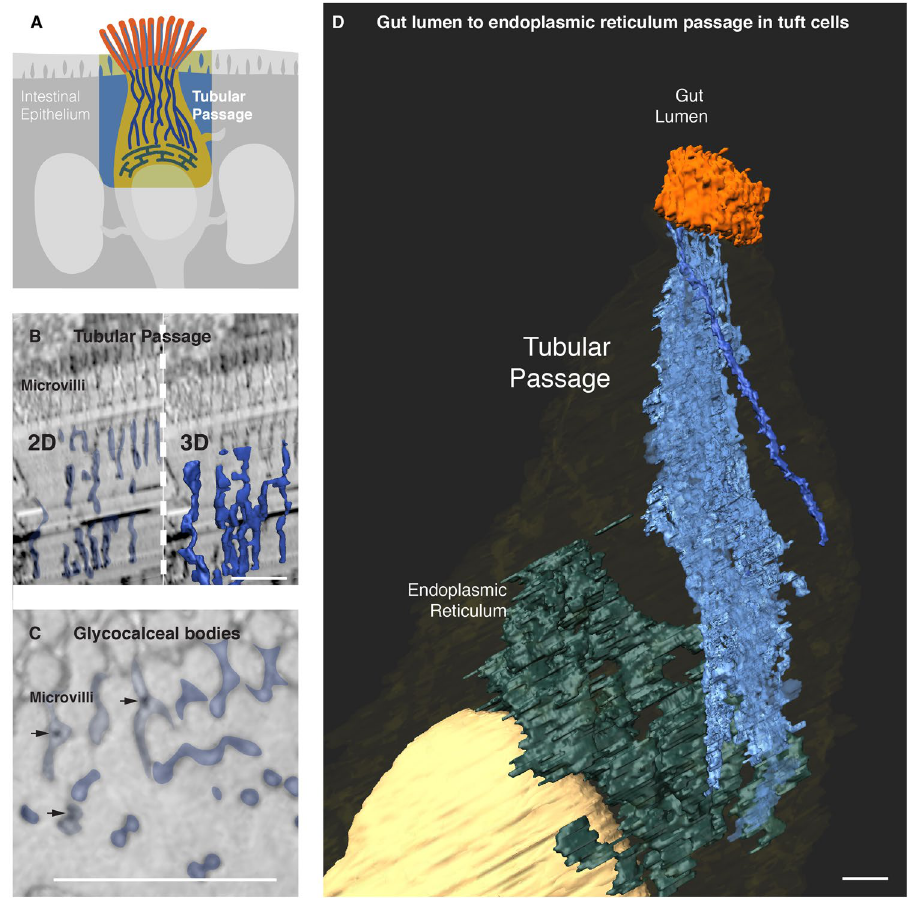
Figure 4. A molecular passage to the endoplasmic reticulum. ( A ) An overview of a passage in the tuft cell connecting its endoplasmic reticulum to the gut lumen. ( B ) A continuous tubular passage starting at the base of the tuft cell microvilli (left) becomes evident after volume rendering of ATUM images (right). ( B ) Glycocalceal bodies (arrows) were observed within microvilli as well as within the tubular passage. ( D ) Volume rendering of ATUM images reveals a passage in tuft cells. It is formed by tubules that start at the base of the microvilli and extend to the endoplasmic reticulum. The tubules appear to merge with the endoplasmic reticulum but this cannot be discerned at the current resolution (4 nm/pixel). See also Video 2. Bars = 1 µ